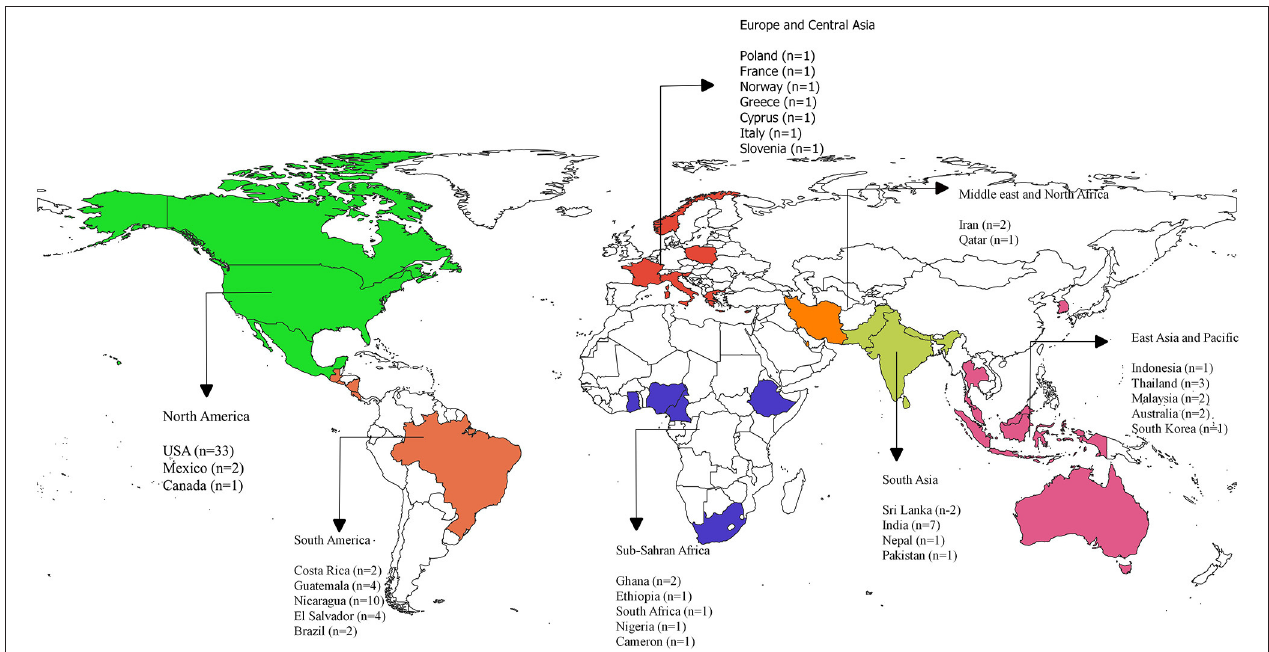
FIGURE 2 | Geographical distribution of the included studies. “ n ” denotes the number of publications in each country; USA, United States of America.